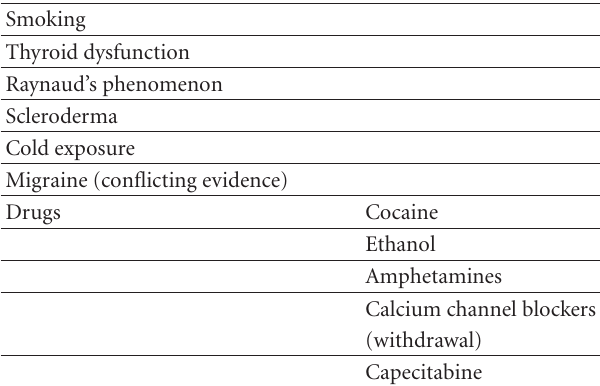
Table 1: Associations of coronary artery